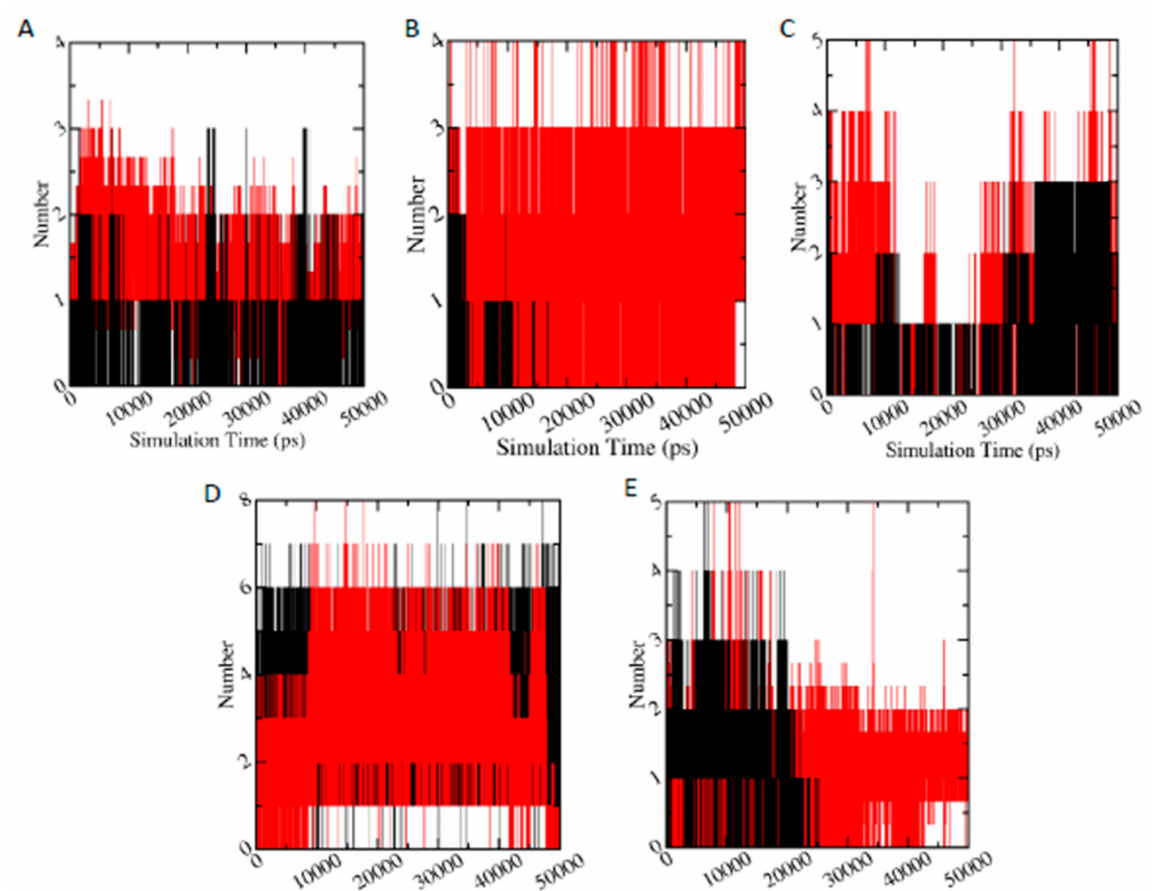
Figure 8. Number of hydrogen bonds versus simulation time (pS), where black and red color plots represent the parent pesticide and metabolite, respectively. ( A – E ) indicate AChE-FM/FMS, AMPK-FN/FNS, ASK1-FM/FMS, GST-IM/6-CIPHD, and PKC-IM/6-CIPHD complexes,